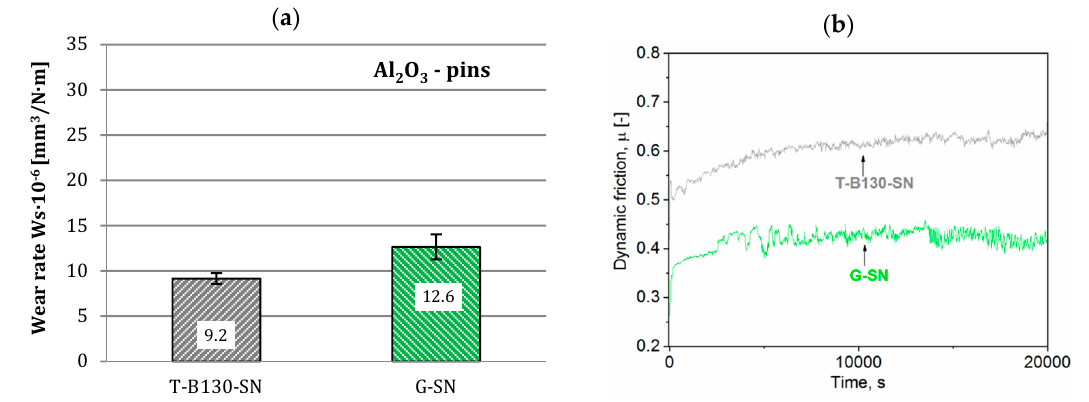
Figure 17. Wear rates ( a ) and dynamic friction ( b ) values for Vanadis 8 steel after G-SN and T-B130-SN; Al 2 O 3 pins as counterbodies were used.